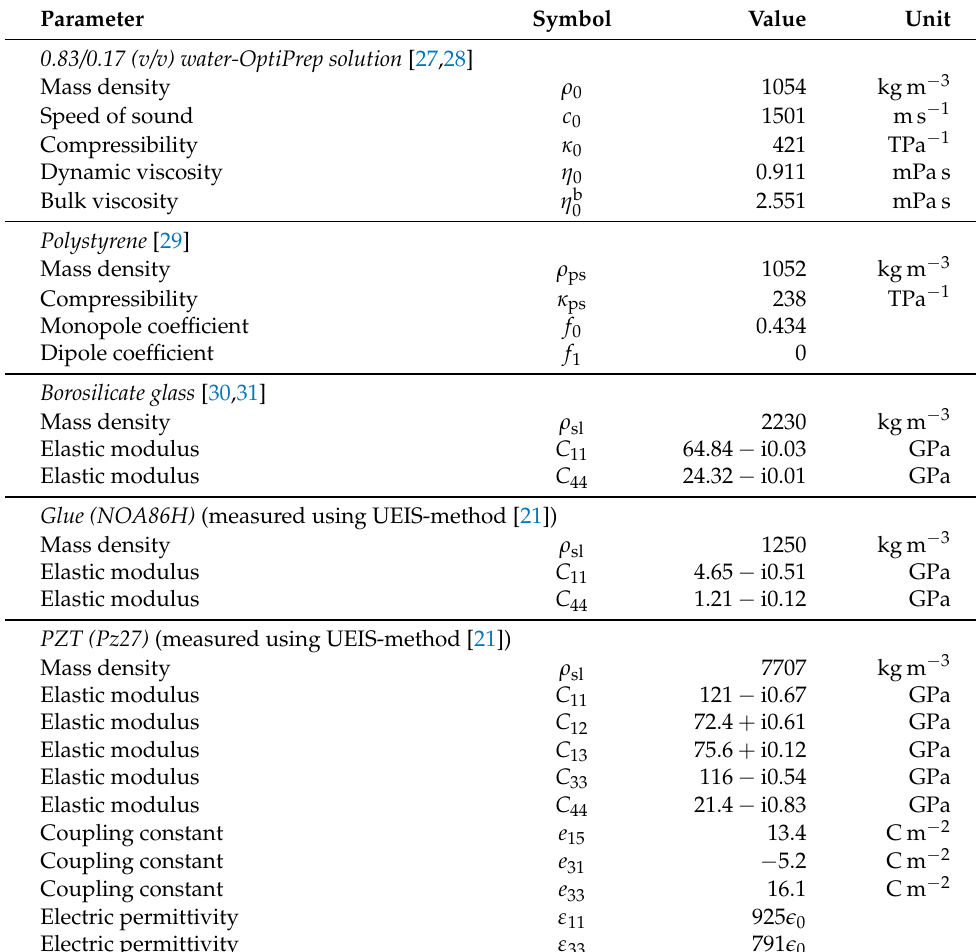
Table A1. List of parameters at 24 ◦ C used in the numerical simulation: the aqueous OptiPrep solution, 10 µ m-diameter polystyrene particles, borosilicate glass, glue, and PZT. For PMMA C 12 = C 11 − 2 C 44 . For PZT C 12 = C 11 − 2 C 66